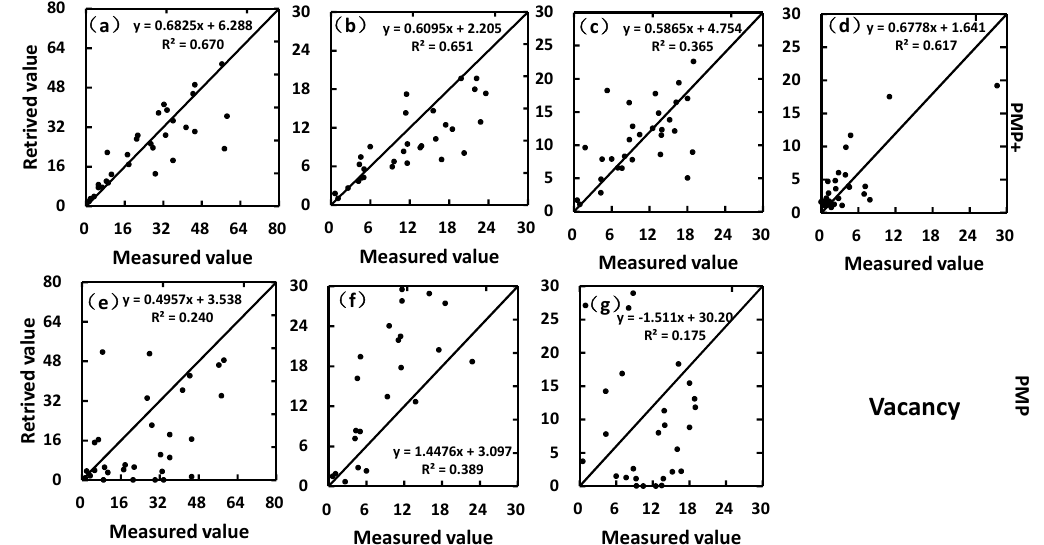
Figure 8. Comparison between measured and retrieved pigment content ( µ g / cm 2 , (leaf sample number n = 28) from PROSPECT-MP+ (PMP+) and PROSPECT-MP (PMP). ( a , e ) are for Chla; ( b , f ) for Chlb; ( c , g ) for Cars; and ( e ) for Ants.